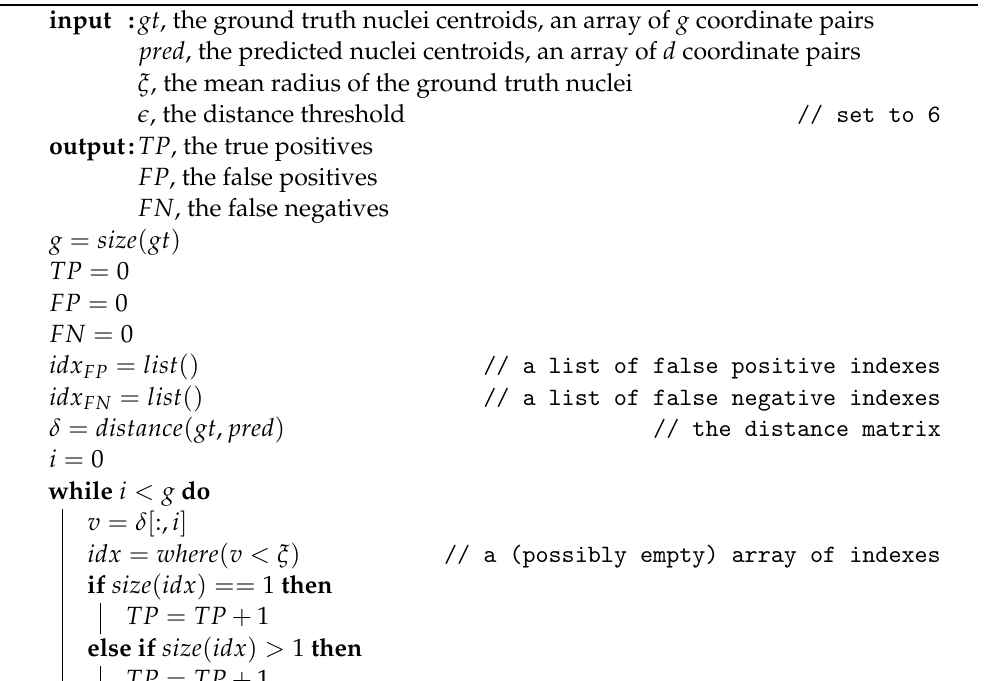
Algorithm 1: Object Detection TP, FP, FN